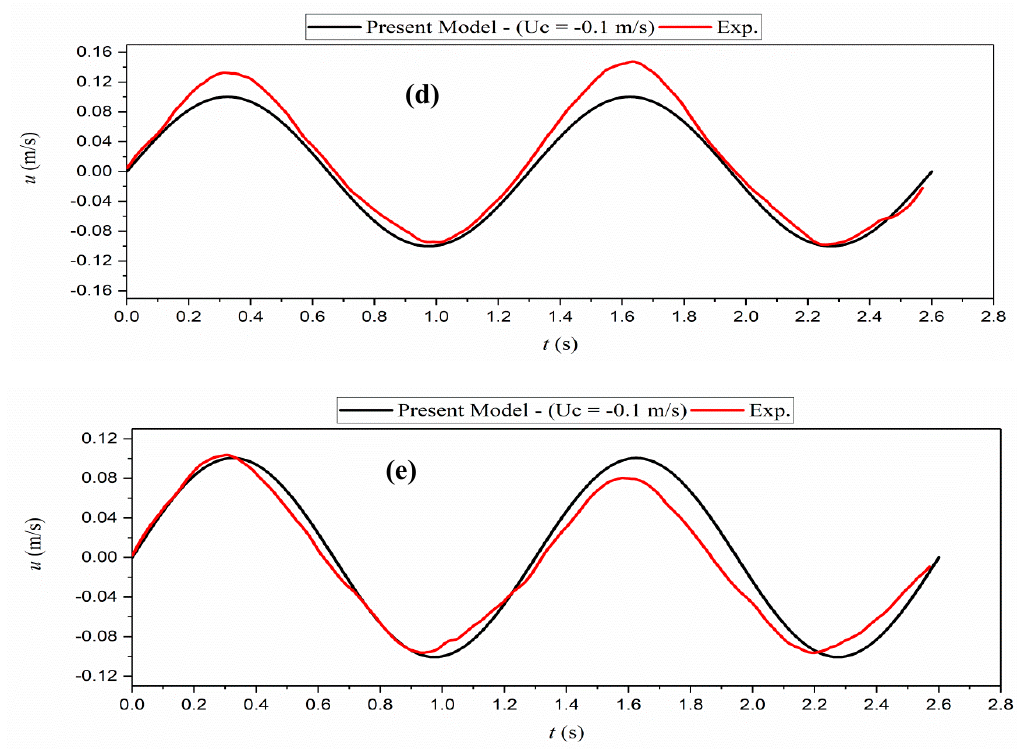
Figure 15. Time series of velocity for T =1.3 s, H =0.05 m, U c =-0.1 m/s; W =160%; ( a ) 0.02 m; ( b ) 0.05 m; ( c ) 0.085 m; ( d ) 0.12 m; ( e ) 0.135 m above the rigid bed.